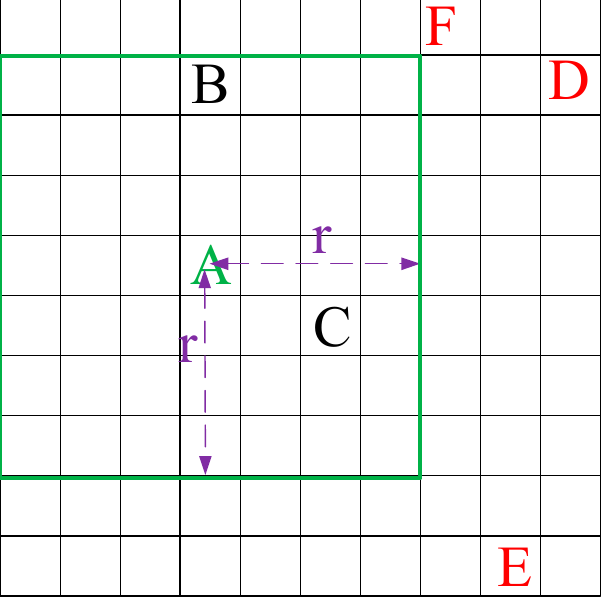
Figure A1. Schematic diagram of weighted coefficient calculation of peak aggregation number.